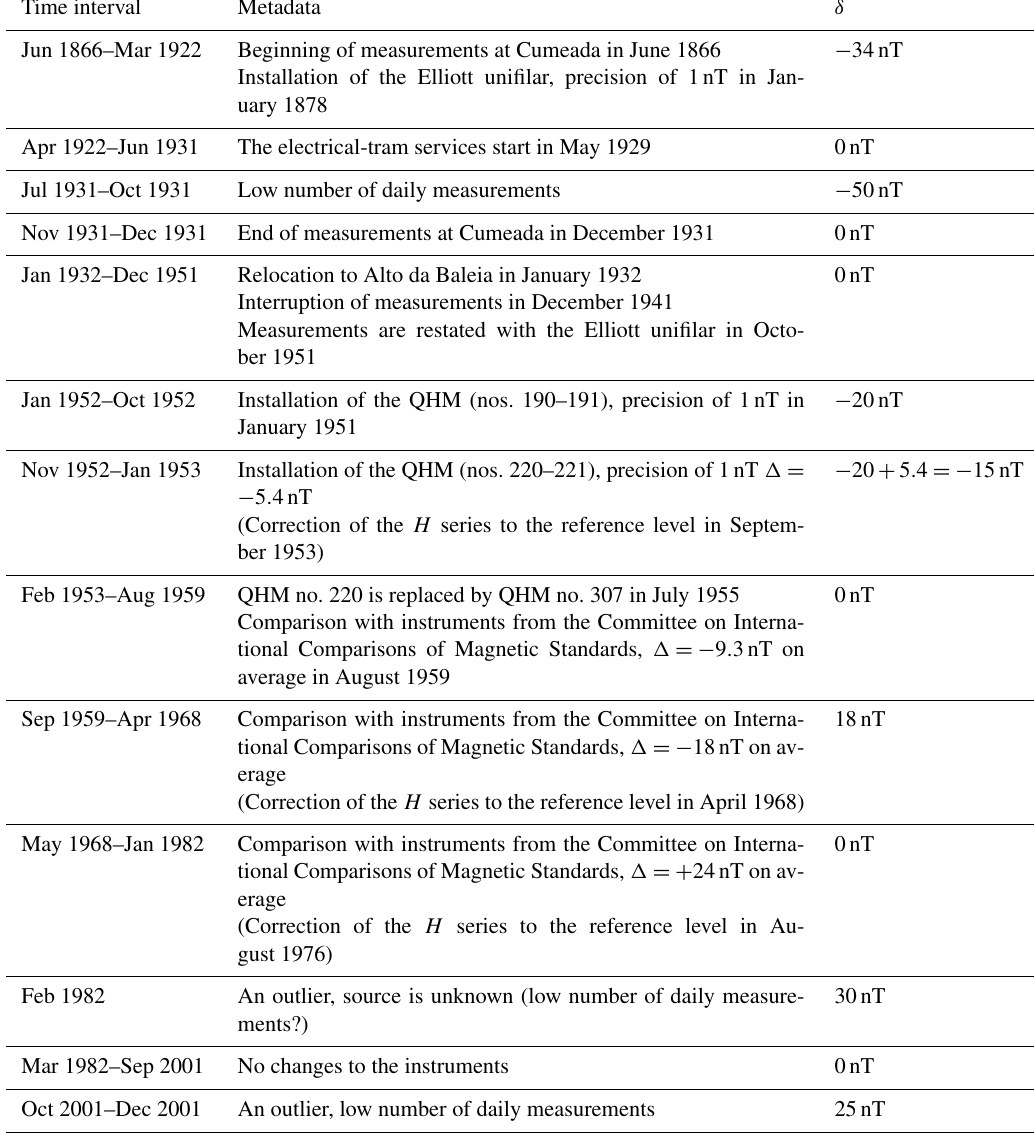
Table 1. Metadata for the H data set at the Cumeada and the Alto da Baleia sites: dates of the instrument replacements, relocations, changes to the measurement and calculation procedures, etc. Estimated corrections ( δ ) for the COI series for different time intervals are in the third